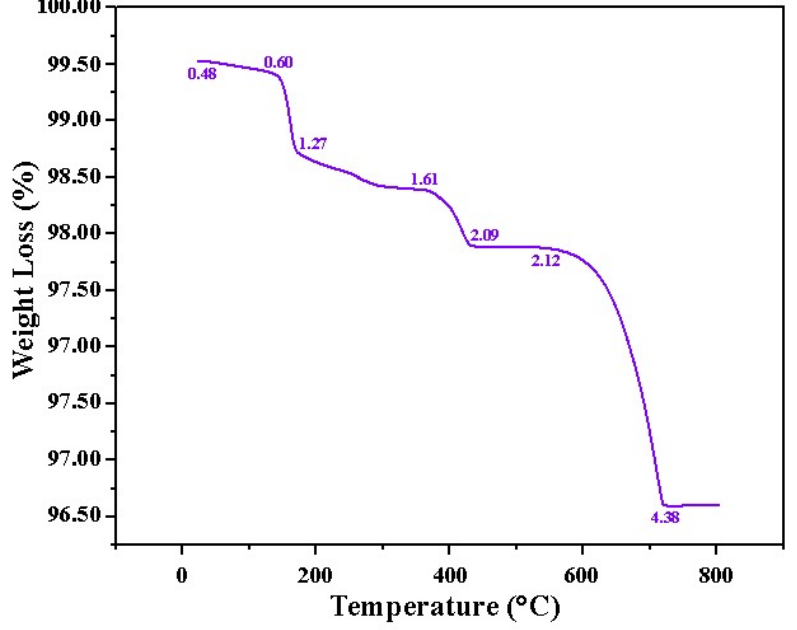
Figure 4. TGA curve of ZnO/CuO indicating the high thermal stability of nanocomposite.